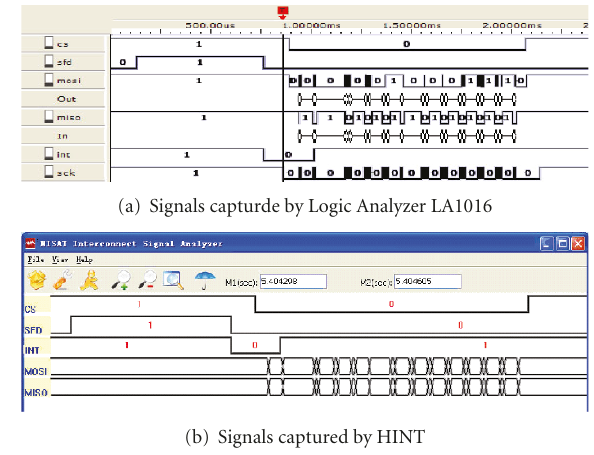
Figure 17: Comparison of logic signal acquisition.